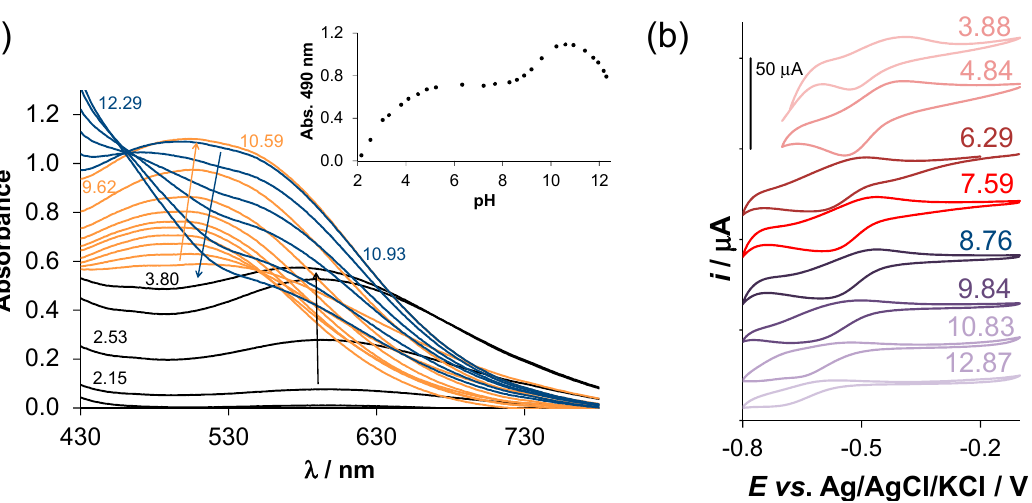
Figure 7. ( a ) Concentration distribution curves of the Fe(III)—Pro-SISC-Me (1:2) system in 30% ( v / v ) DMSO/H 2 O. ( c ligand = 1 mM; T = 25 ◦ C; I = 0.10 M (KCl)); ( b ) Predominance curves calculated for the hypothetic Fe(III)—SISC—Pro-SISC-Me (1:2:2) system on the basis of the overall stability constants to reveal the ligand preference of Fe(III). ( c Fe(III) = 0.5 mM; T = 25 ◦ C; I = 0.10 M (KCl)).